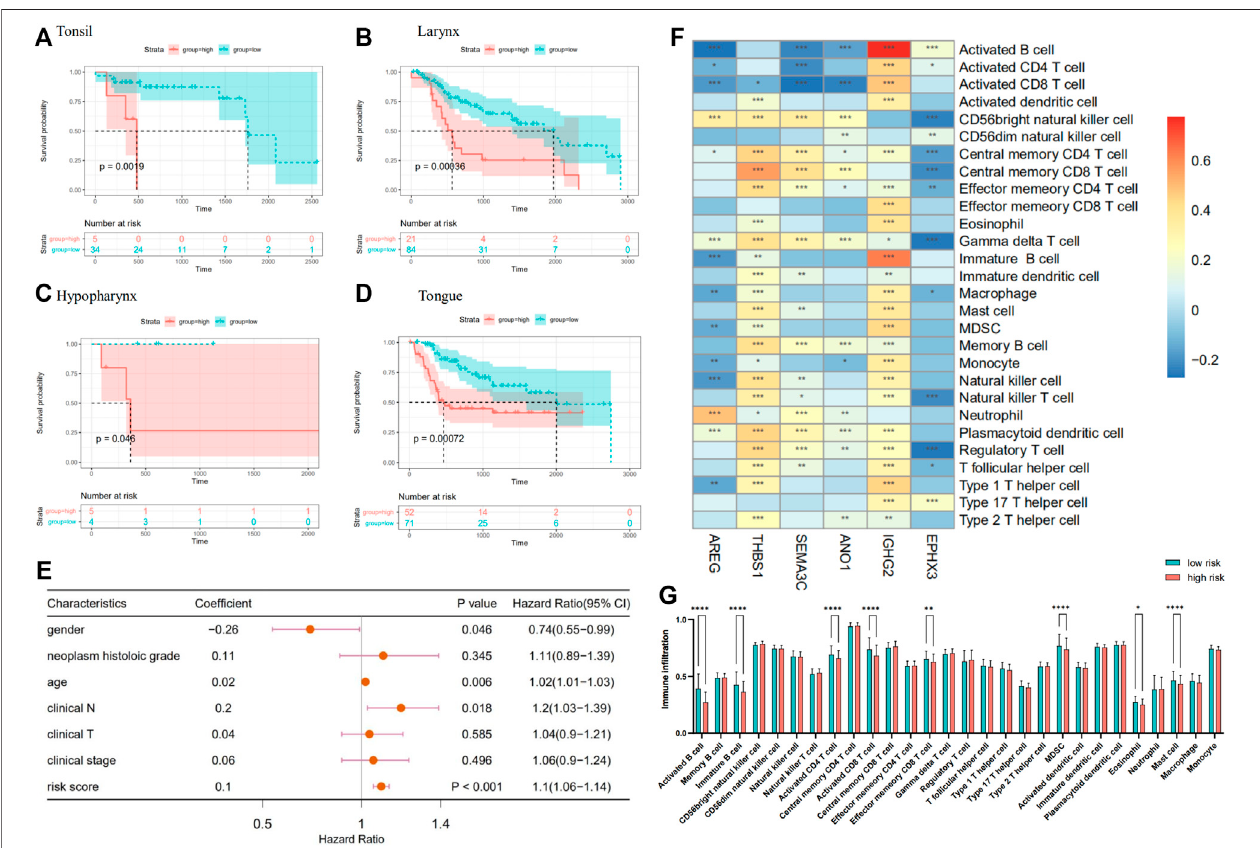
FIGURE5|(A – D) AKaplan – Meierplotestablishesthesurvivaldifferencesbetweenhigh-andlow-riskgroupsinHNSCCwithdifferentprimarysites. (E) Forestplot of other clinical characteristic and risk scores on a univariate Cox regression analysis. (F) Heatmap plotted by the correlations between the expression of genes in prognostic model and immune in fi ltrate level in HNSCC. (G) Comparison of immunocyte in fi ltration between high- and low-risk groups.